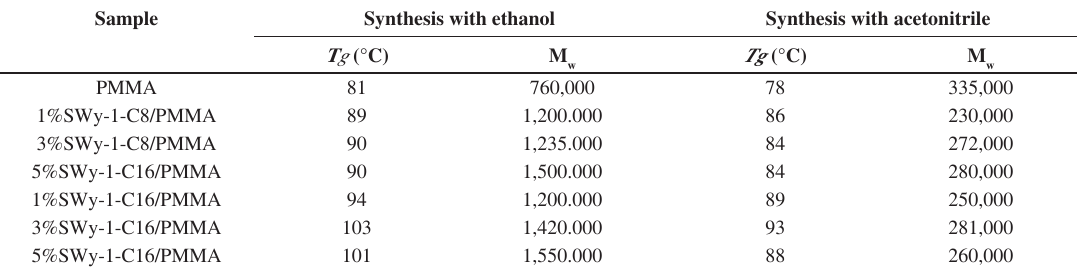
) of PMMA and its nanocomposites. w